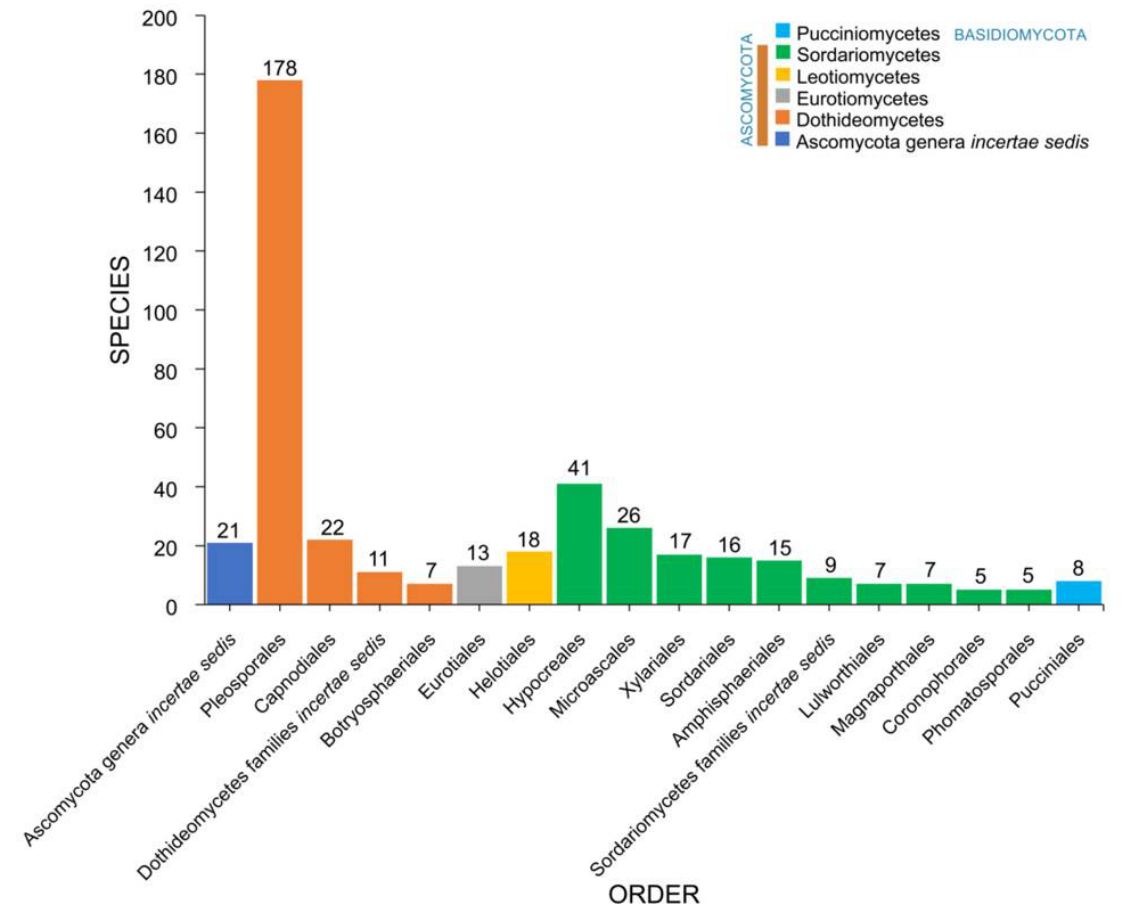
Figure 6. The distribution of salt marsh fungi in major fungal orders.